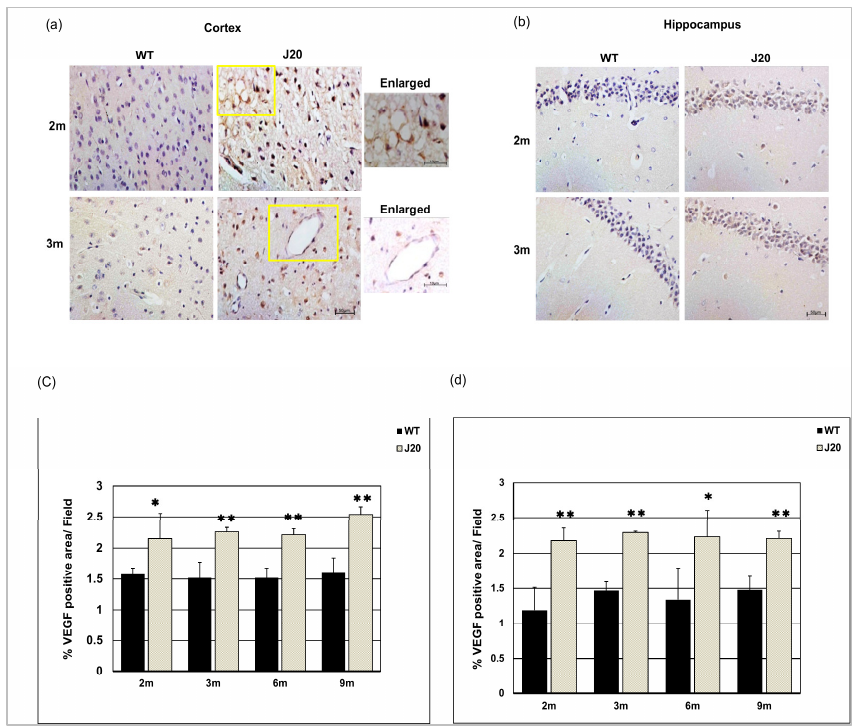
Figure 8. Increased expression of vascular endothelial growth factor (VEGF) levels in J20 mice brains. Immunostaining of VEGF in the cortex ( a ) and hippocampus ( b ) of both WT and J20 mice brains at 2 and 3 months. The yellow boxed areas were magnified. Scale bar = 10 µm. Densitometric analysis by ImageJ as a percentage of VEGF positive area per field (×40) in the cortex ( c ) and the hippocampus ( d ) were shown in the graph. Numerical data are presented here as average ± SD, and statistical significance is denoted as * p < 0.05, ** p < 0.01 vs. age-matched WT. M indicates the month. Scale bar = 50 µm.